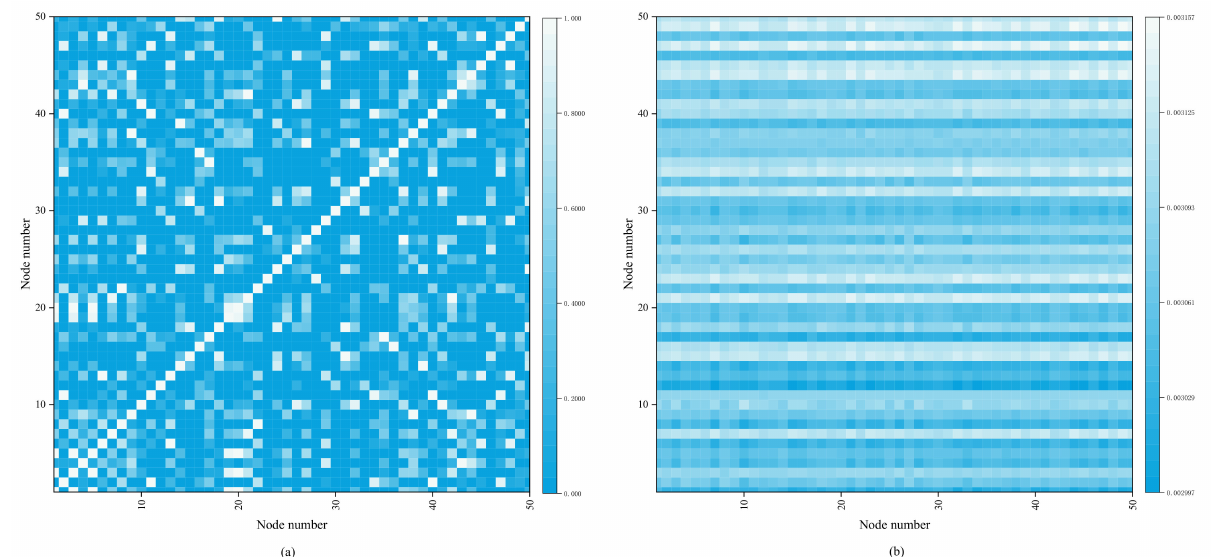
Figure 7. Component analysis of STAWGNN on the PEMSD7(M) dataset.